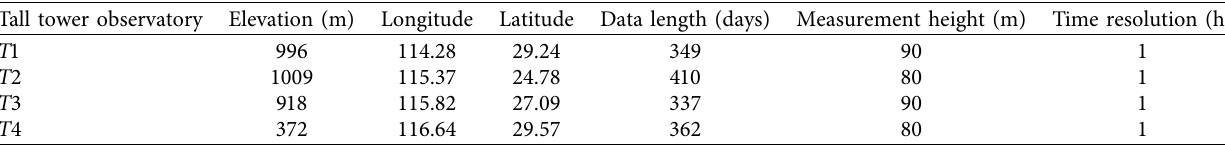
Figure 1: Geographical information for the tall tower Table 1: General information for the tall tower observatories.